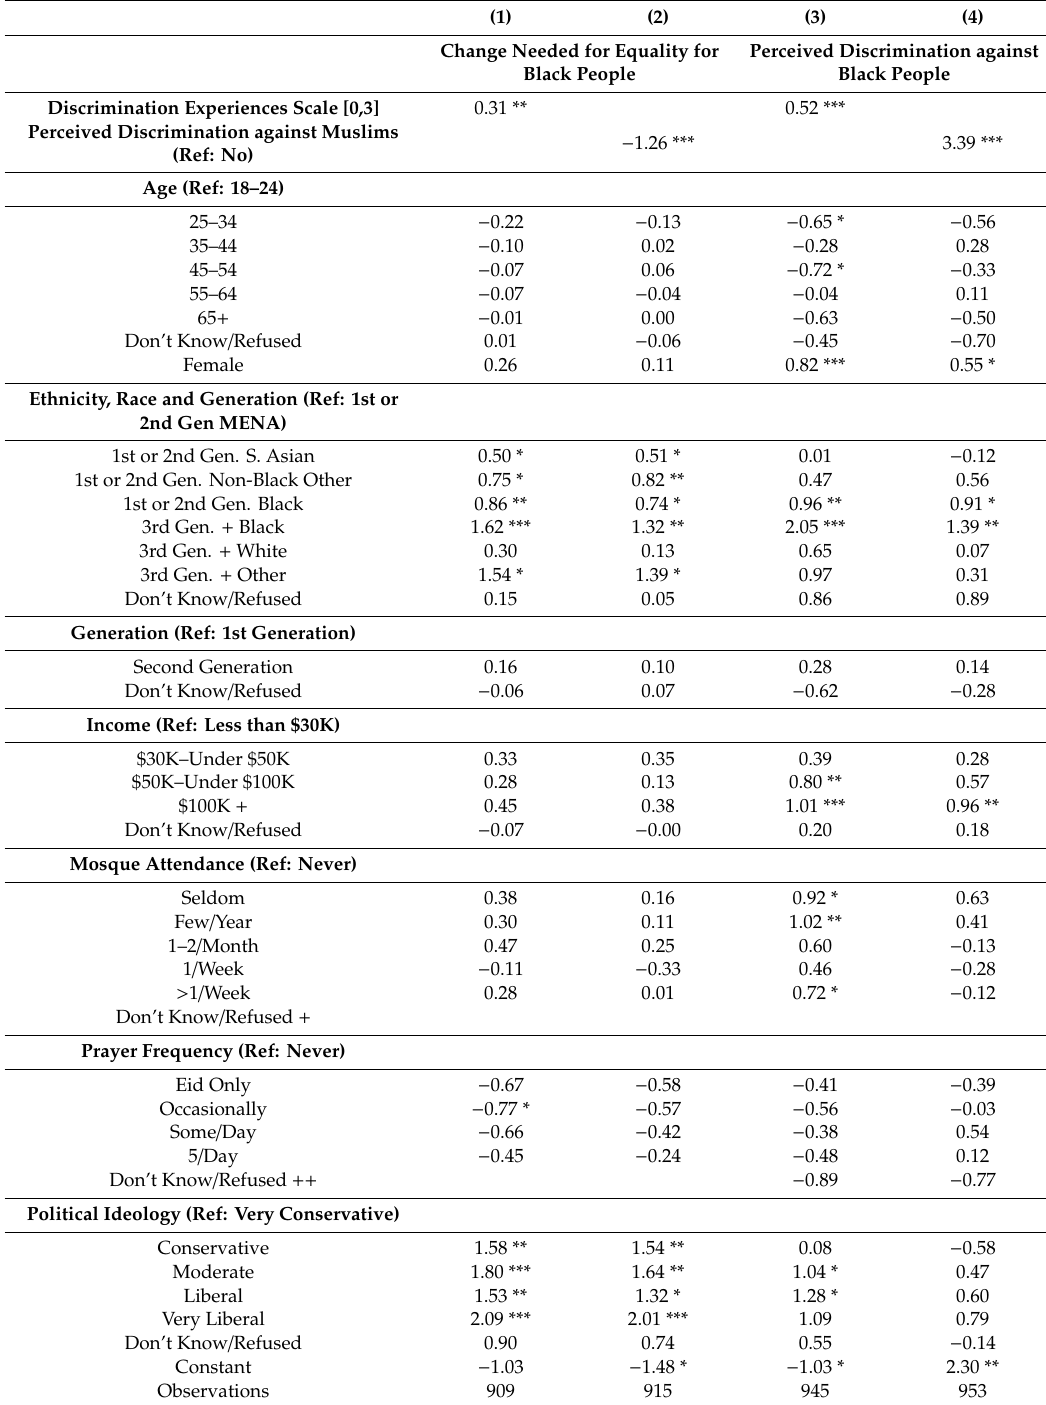
Table 2. Coe ffi cients from Logistic Regression Predicting Solidarity with Black People. (1) (2) (3)